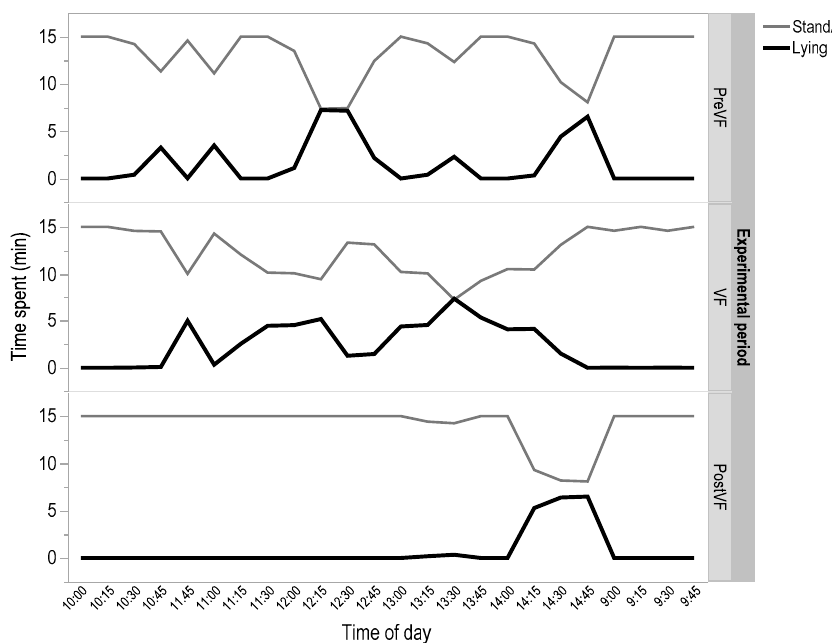
Figure 3. Mean time within 15-min sample intervals that sheep (n = 6) spent lying or standing